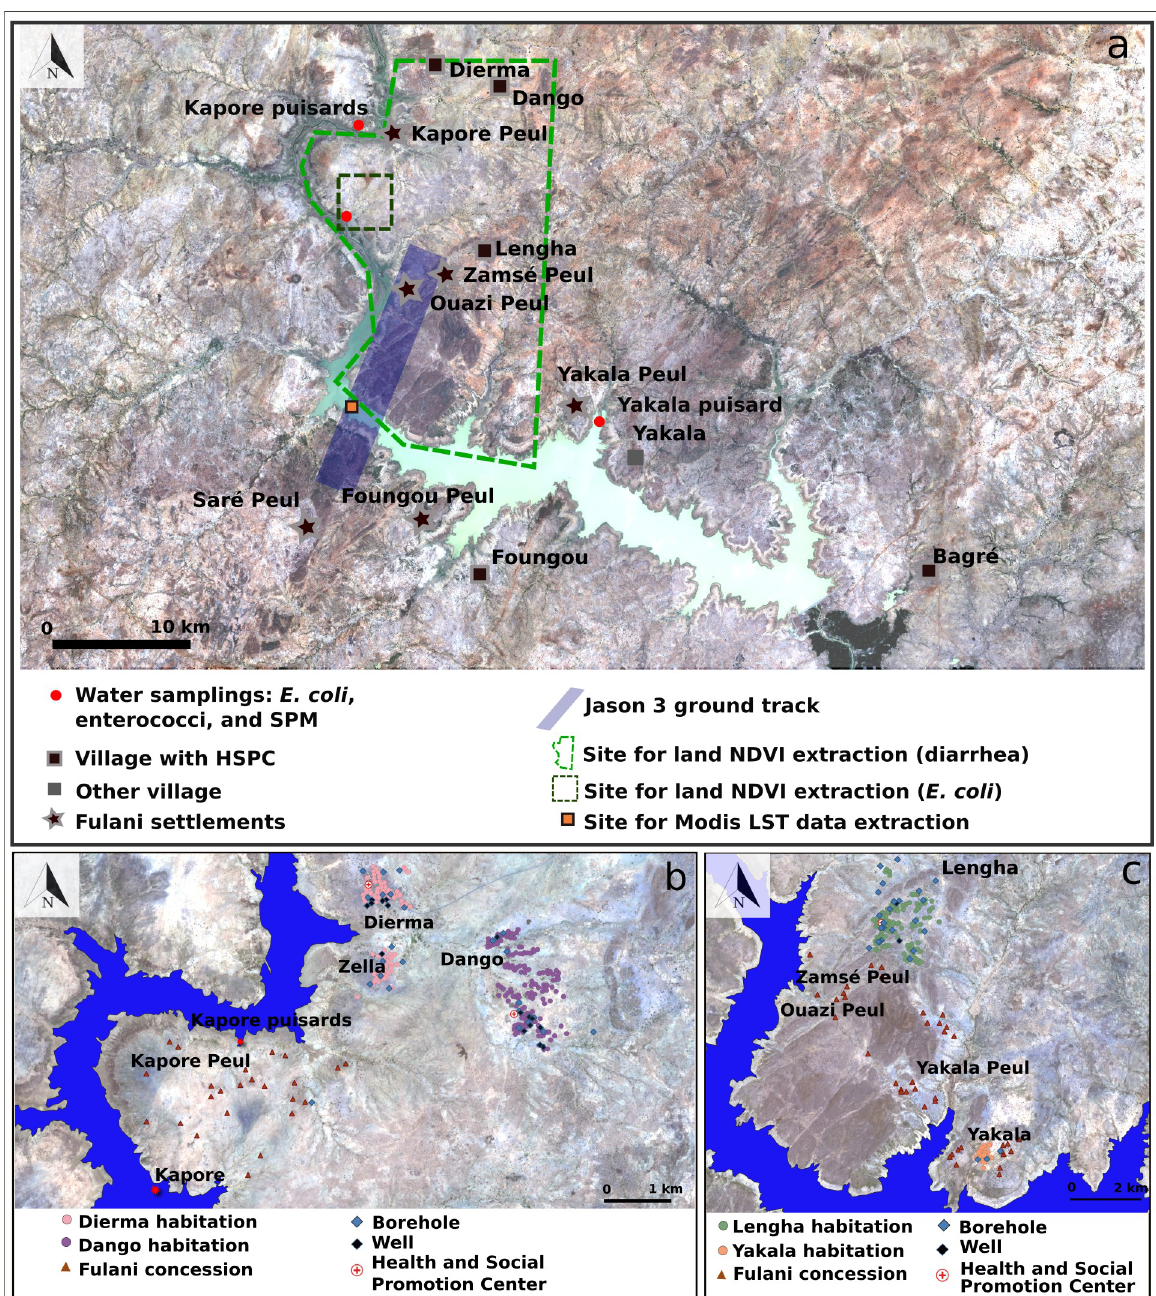
Fig 1. (a) Study Area (Sentinel-2 image 22/04/2018 - https://theia.cnes.fr/atdistrib/rocket/#/collections/SENTINEL2/8fb3429b-1ffc-53ff- bfb2-b5c75aba877f); (b) Zoom on the area of Dango, Dierma and Kapore; (c) Zoom on the area of Lengha, Lengha Peul, Yakala and Yakala Peul